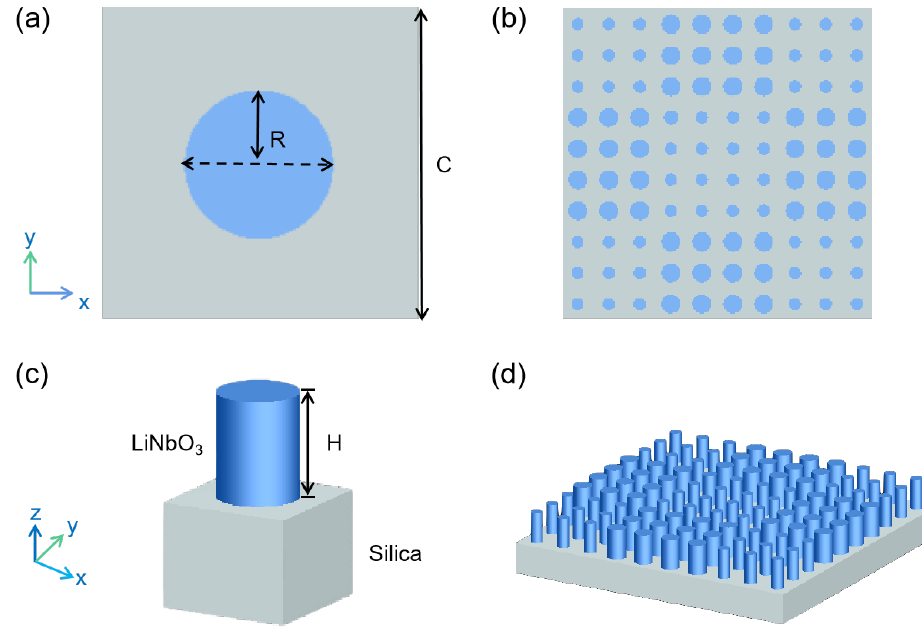
Figure 3. ( a ) Top view of straight waveguide nanorod unit. ( b ) DG metasurface with two sizes of LN straight waveguide nanorods R 1 = 140 nm and R 2 = 183 nm on the silica substrate. ( c ) Structure diagram of the unit nanorod with size C = 600 nm and height H = 1000 nm. ( d ) The planform of straight waveguide DG metasurface.